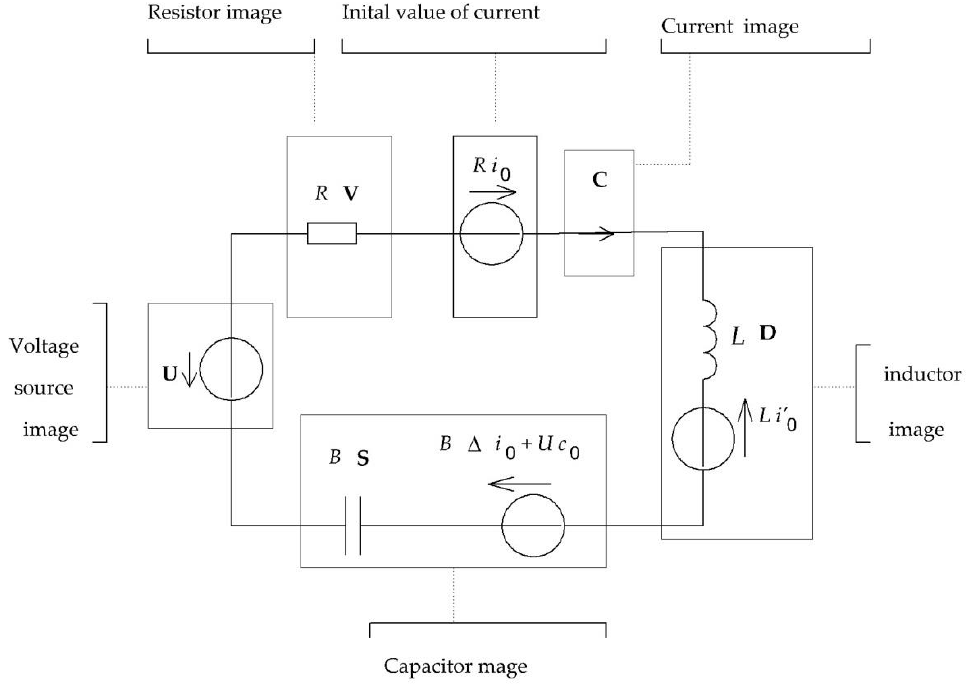
Figure 2. Equivalent scheme of R-L-C-e circuit.